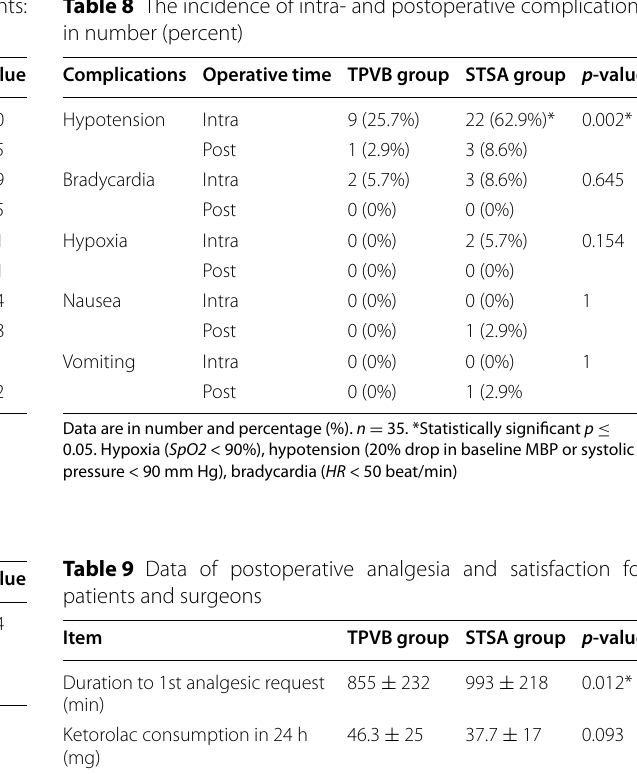
Table 7 Intraoperative Ramsay sedation score of the two groups